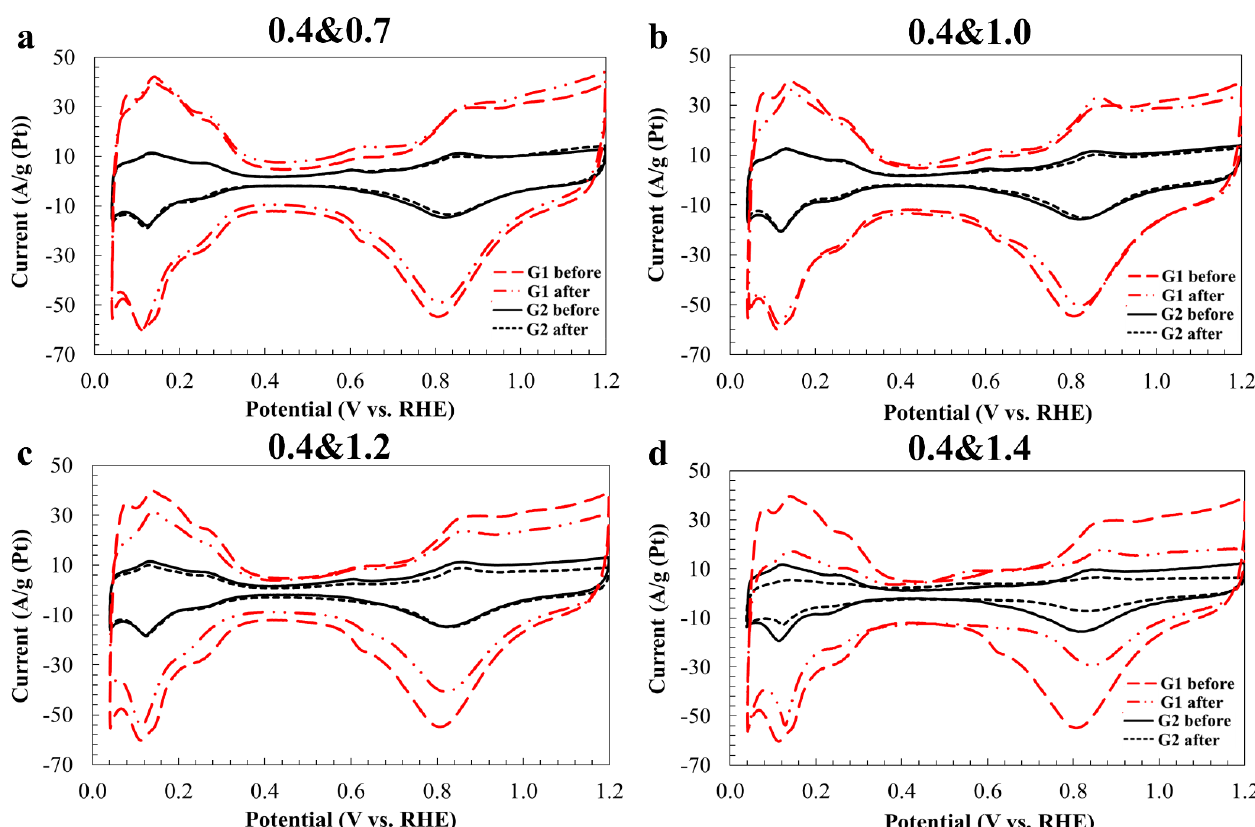
Figure 7. 2 CVs of Pt/C catalysts before and after different ADT protocols: ( a ) 0.4 and 0.7 V; ( b ) 0.4 and 1.0 V; ( c ) 0.4 and 1.2 V; and ( d ) 0.4 and 1.4 V. The potential scan rate is 20 mVs − 1 , the electrolyte is 0.1 М HClO 4 , and Т = 60 °С.